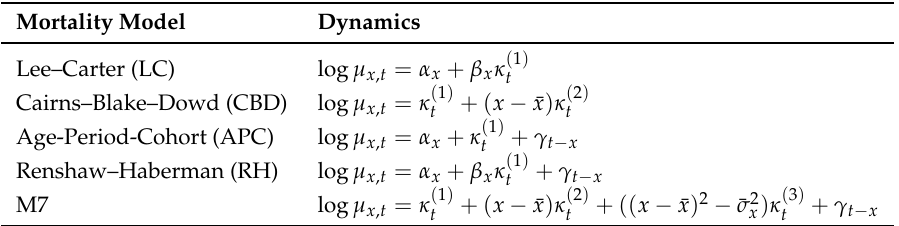
Table 1. Model structures considered for comparison.